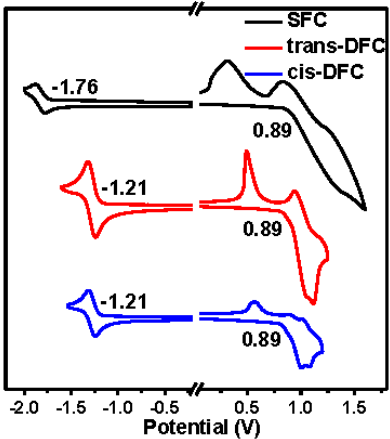
Figure 6. Cyclic voltamogram of SFC, trans -DFC, and cis -DFC measured in dry CH 2 Cl 2 (oxidation) and DMF (reduction) with 0.1 M Bu 4 NPF 6 as supporting electrolyte, at a scan rate of 100 mV s − 1 .